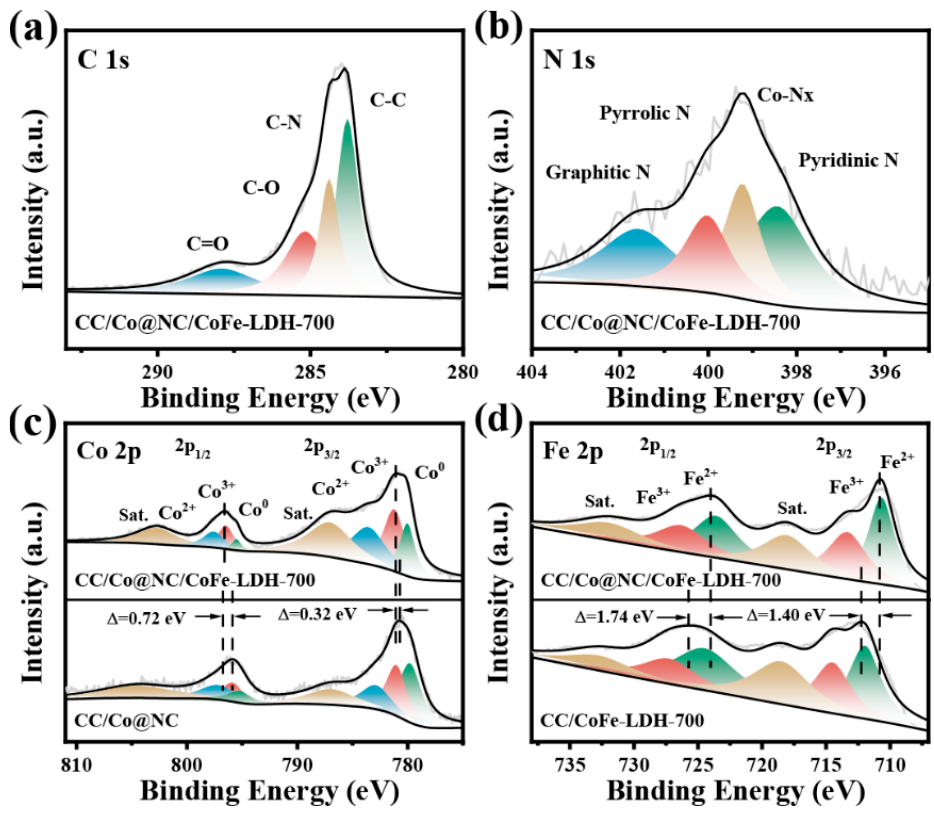
Figure 3. High-resolution XPS spectra of ( a ) C 1s, ( b ) N 1s, ( c ) Co 2p, and ( d ) Fe 2p for related sam-